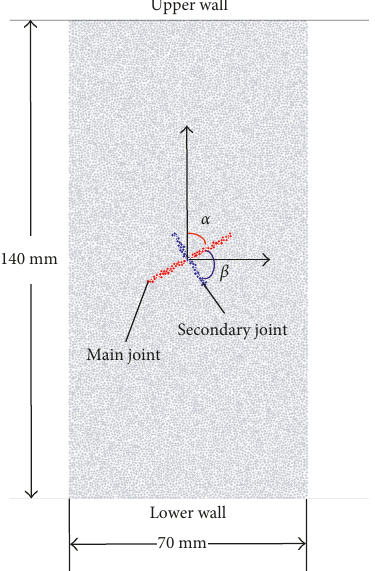
Figure 3: Simulation model for the granite specimen with a set of cross-joints with different lengths.